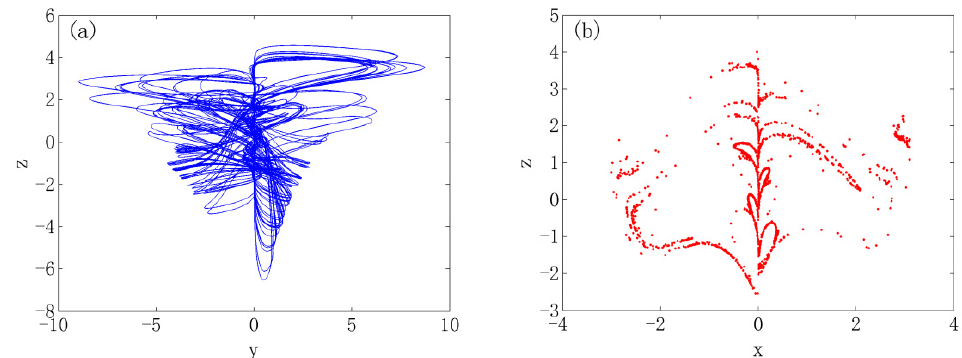
Figure 6. Hidden chaotic attractor of system (4) when β = 0.30. ( a ) Phase trajectory diagram in yz plane; ( b ) Poincare map in xz plane.